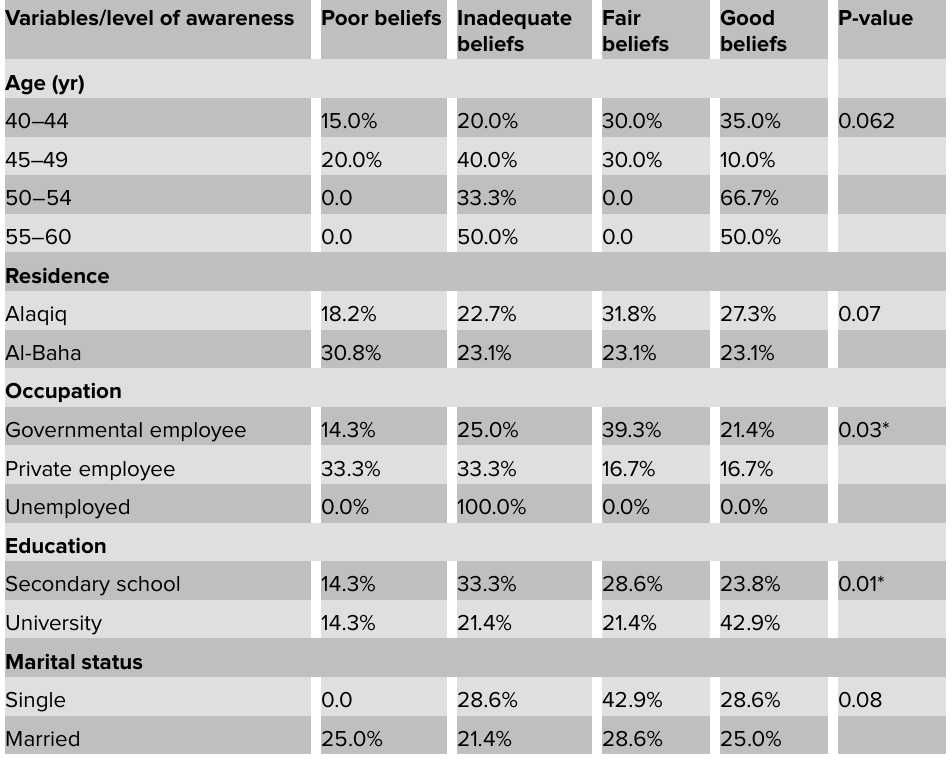
Table 5: Relationship between demographic variables, and the level of women’s beliefs, n =